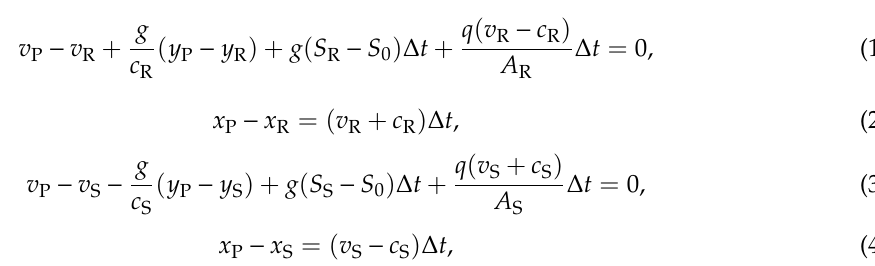
Figure 1. Meshes of open channel flow. where A, B and P are the gird nodes in the meshing of pressured flow, R and S are the modified adjacent nodes in free surface flow. C + and C - are the characteristic lines.